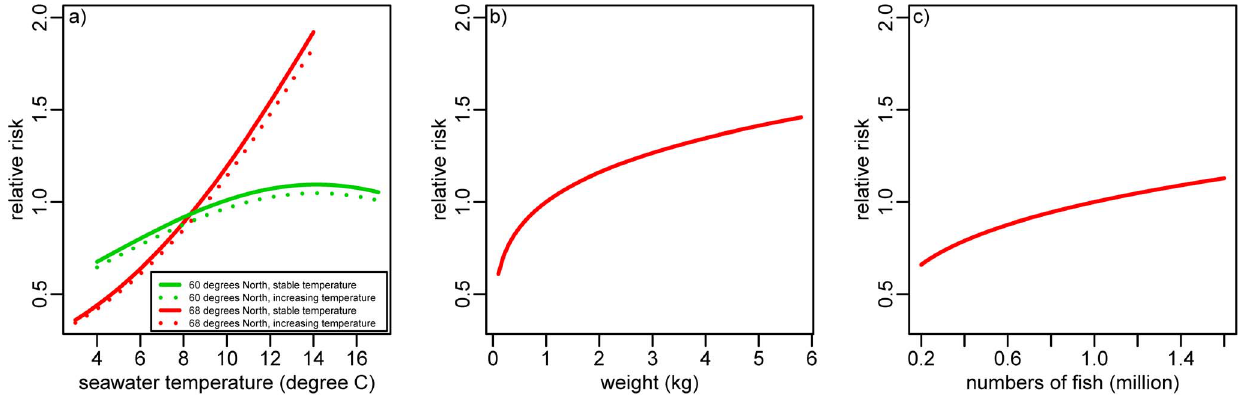
Figure 5. Estimated relative effects of the seawater temperature (a), of the mean fish weight (b) and of the number of fish at neighbouring farms